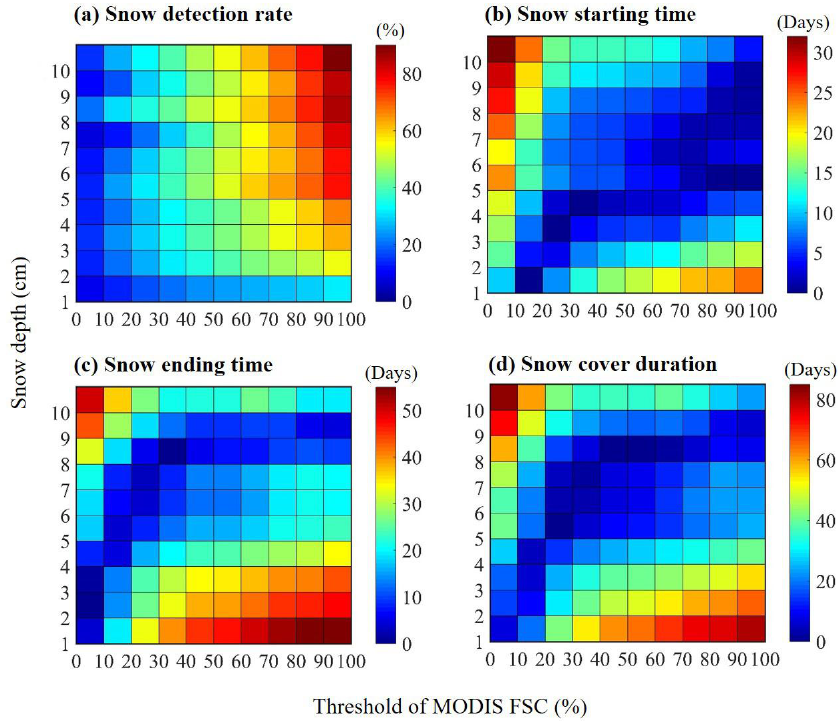
Figure 11. Sensitivity analysis to snow detection rate ( a ), snow starting time ( b ), snow ending time ( c ), and snow cover duration ( d ) related to the choice of the snow depth and FSC threshold values. Percentages (%) indicate the accuracy; days indicate the absolute difference between in situ derived and MODIS-derived snow-cover phenology (i.e., snow starting time, snow ending time, and snow cover duration).